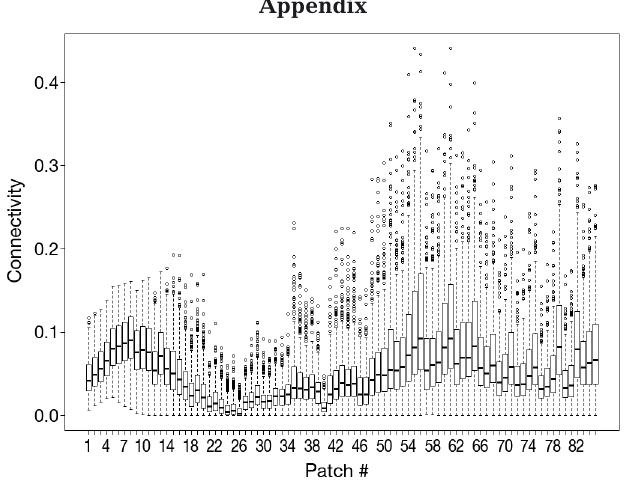
Fig. A1. Distribution of total connectivity between one patch and all other patches of the domain. The probabilities of leaving one patch and reaching another patch in one or several days have been summed up at each time step. Results show the high variability of connectivity due to the changes of the hydrodynamic conditions. They also highlight that patches 21 to 26 have the lowest connectivity, with average values close to 0. The connectivity matrix was of dimensions L × M × N × P , where L is the number of dates, N is the number of emission patches, and P is the number of reception patches ( N = P in these simulations). The connectivity matrix used was as follows: Connectivity[30,10,20,50] represents: day no. 30; time step no. 10 (i.e. 10×12 h = 120 h after release; emission from patch 20; and reception at patch 50. For instance, Connectivity [30,10,20,50] = 0.001 indi- cates that if one pathogen was released at the beginning of run 30 from patch 20, the probability that the pathogen will reach patch 50 after 120 h is